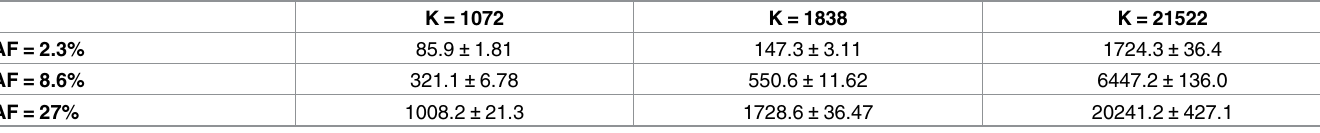
Using Eq 1, a maximum handling time of 240 seconds, and scaling factors to account for different handling characteristics, we again calculated intake using three different values of skin transfer coefficients and three different absorption factors. When calculations evaluated intake using the lowest concentrations reported in thermal paper (0.211 mg/g), the most con- servative estimate of intake is 85.9 ± 1.81 ng/kg/day (Table 3). Calculations using the highest concentrations reported in thermal paper (26.3 mg/g) produce conservative estimates of 10582.9 ± 223.3 ng/kg/day (Table 4). Calculations using the highest skin transfer coefficients and highest absorption factors again suggest much higher intake levels (Tables 3 and 4).